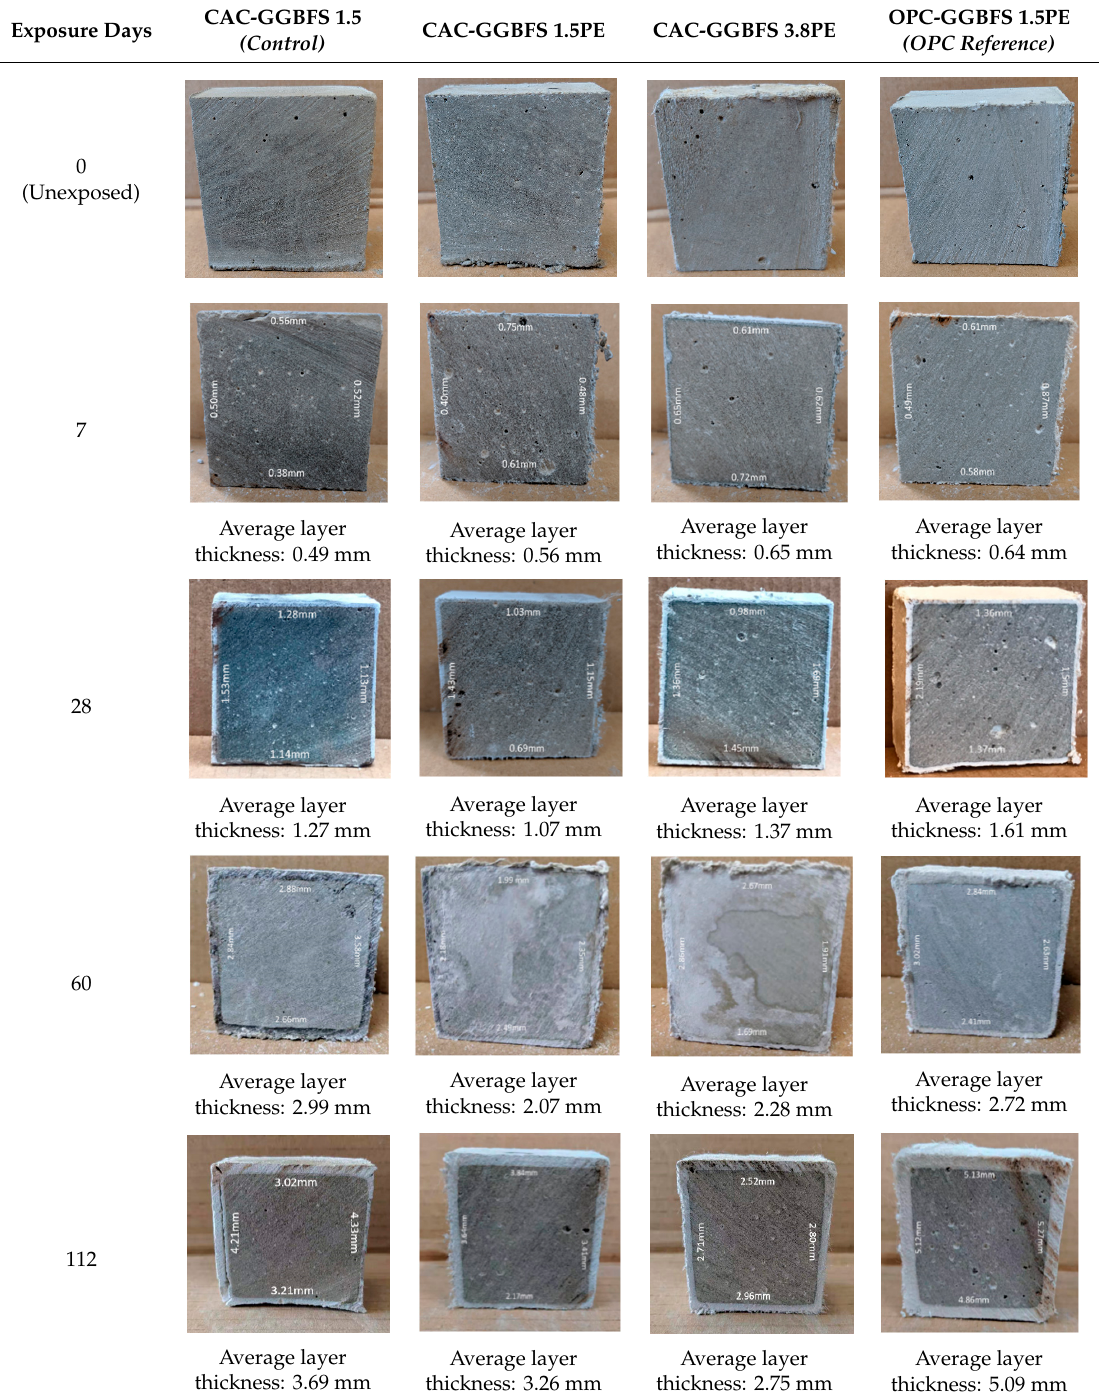
Table 4. Change of cross-section at di ff erent age after acid exposure.